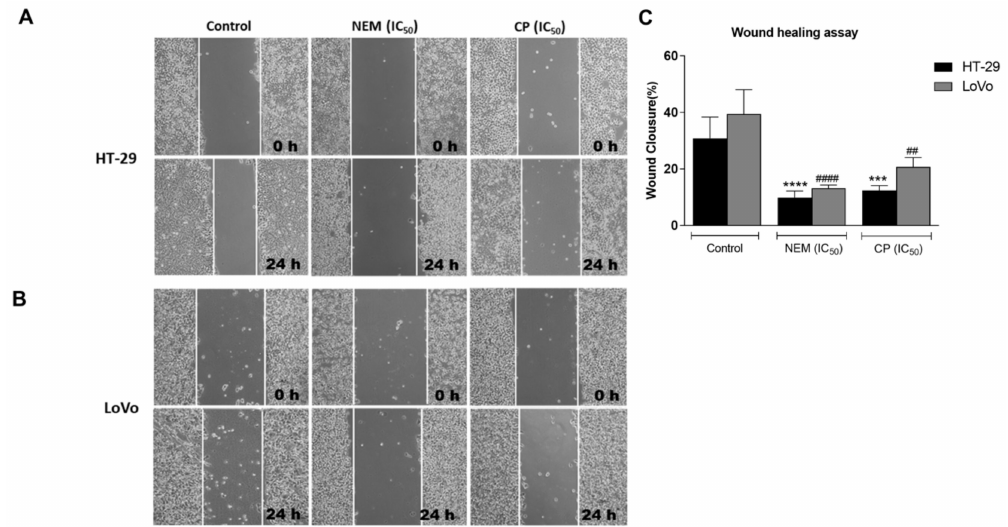
Figure 7. Wound healing assay in the CRC cell lines HT-29 ( A ) and LoVo ( B ; magnification 10 × ). Quantitative analysis of scratch wound healing assay after a 24 h-treatment with NEM or CP (IC 50 / 72 h; C ). Data are expressed as mean ± S.D. of three independent experiments. HT-29 cells: *** p < 0.001, **** p < 0.0001 vs. untreated cells. LoVo cells: ## p < 0.01, #### p < 0.0001 vs. control.